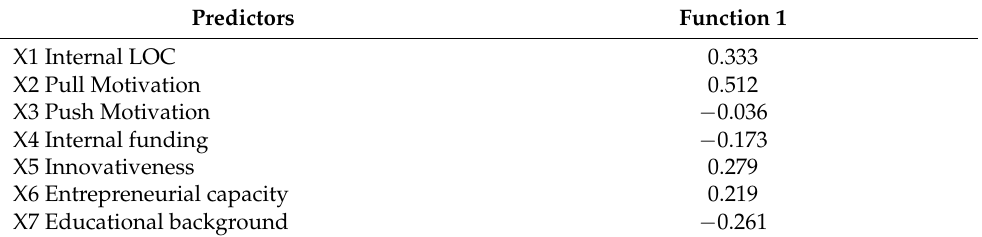
Table 8. Classification results—canonical discriminant function coefficients. Predictors Function 1 X1 Internal LOC